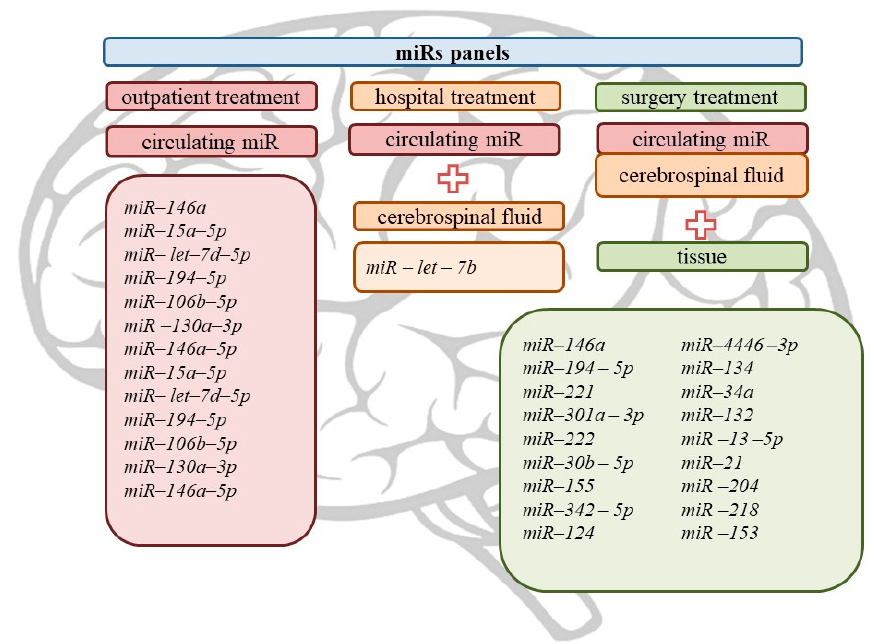
Figure 3. New microRNA diagnostic panels for mesial temporal lobe epilepsy.